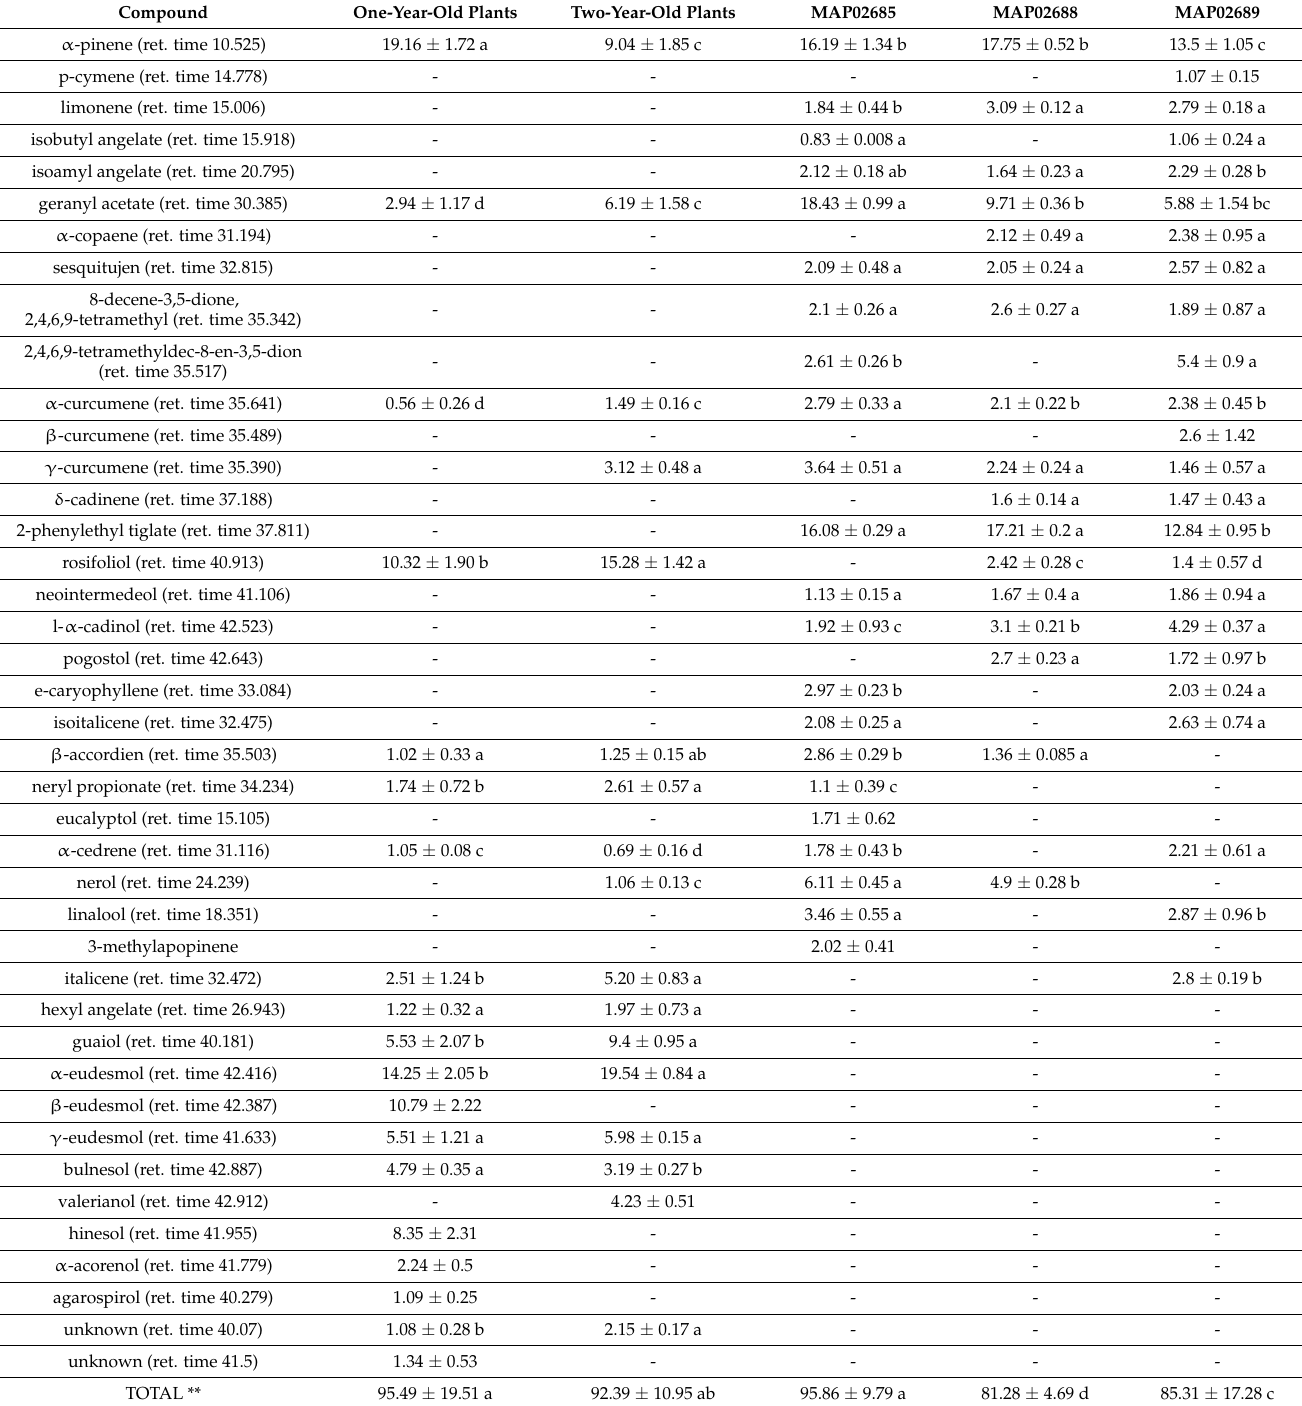
Table 1. Average relative peak area ± standard deviation (SD) (%) of individual compounds in essential oils (average ± SD) in two- and one-year-old immortelle plants ( H. italicum ) and in three Croatian populations (MAP02685, MAP02688, MAP02689) of immortelle plants (H. italicum ). Different letters indicate statistical differences between